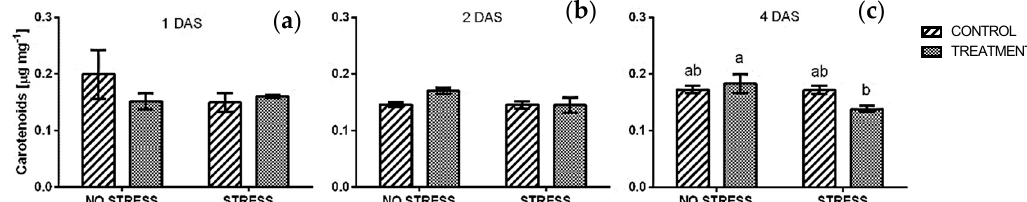
Figure 4. Carotenoids concentration in rocket leaves treated with water (CONTROL) and with borage extract (TREATMENT) and subjected to salt stress (200 mM). Measures were taken after one day ( a ), two days ( b ) , and four days ( c ) of stress. Values are means ± SE ( n = 4). Data were subjected to two-way ANOVA. Different letters, where present, represent significant differences ( p < 0.05).